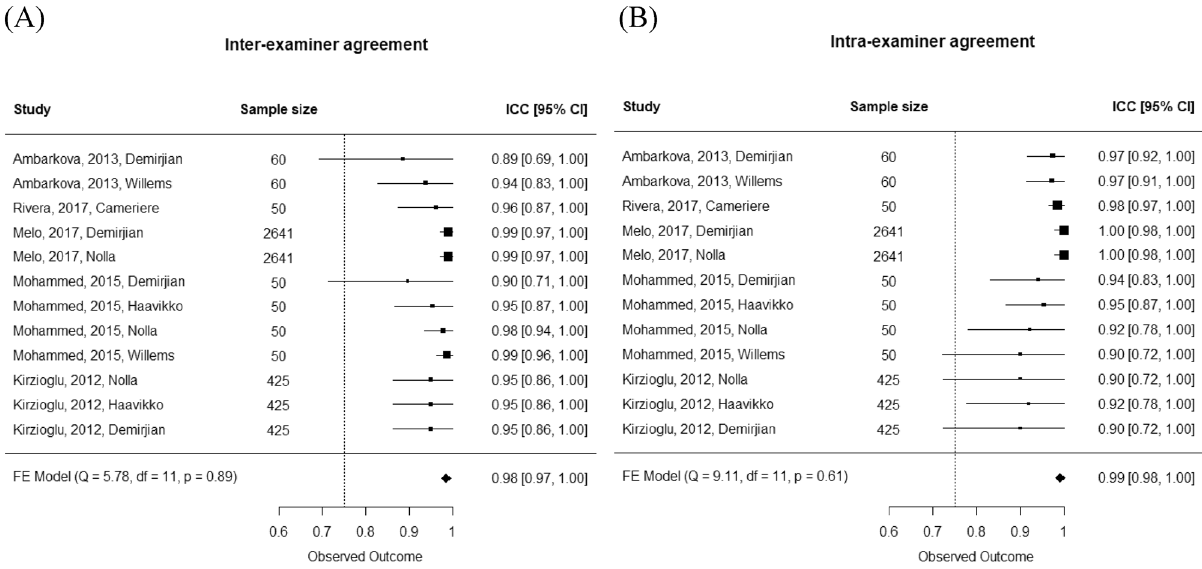
Figure 4. Forest plots showing the pooled inter-examiner ( A ) and intra-examiner ( B )